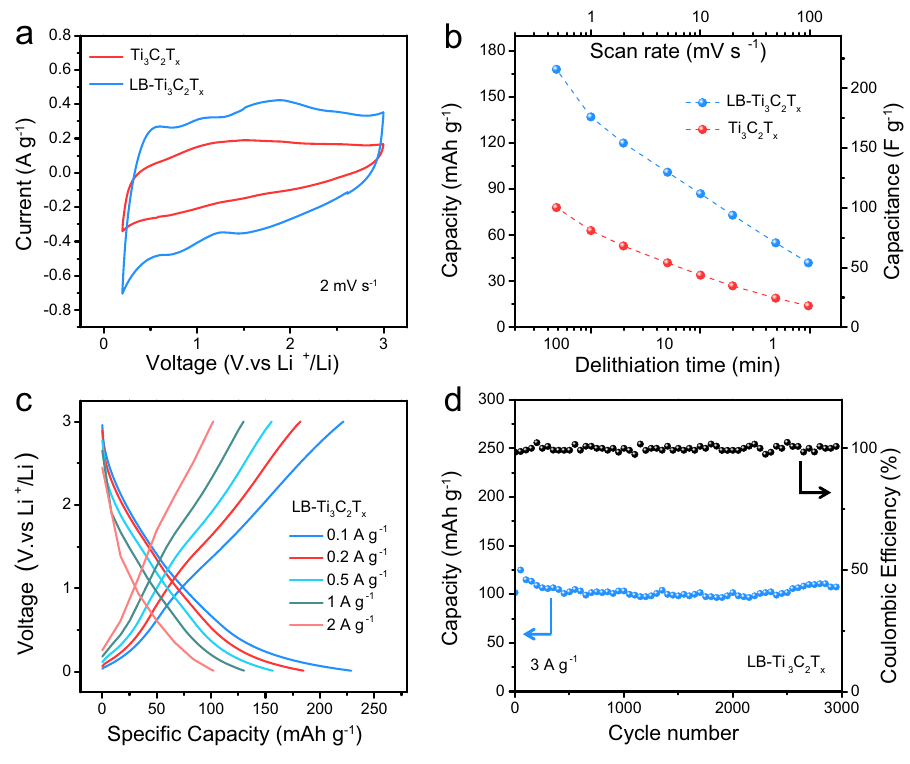
Fig.4|ElectrochemicalenergystoragepropertiesofLB-Ti 3 C 2 T x .a CVpro fi lesof Ti 3 C 2 T x and LB-Ti 3 C 2 T x at scan rate of 2mVs − 1 . b The comparison of capacity of Ti 3 C 2 T x andLB-Ti 3 C 2 T x atvariousscanratesanddelithiationtime. c Voltagepro fi les